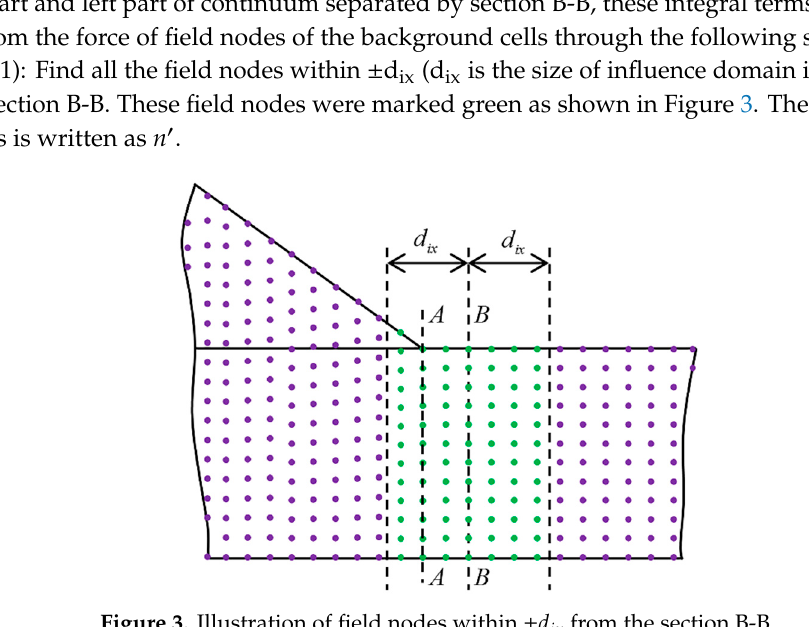
Figure 3. Illustration of field nodes within ± d ix from the section B-B.